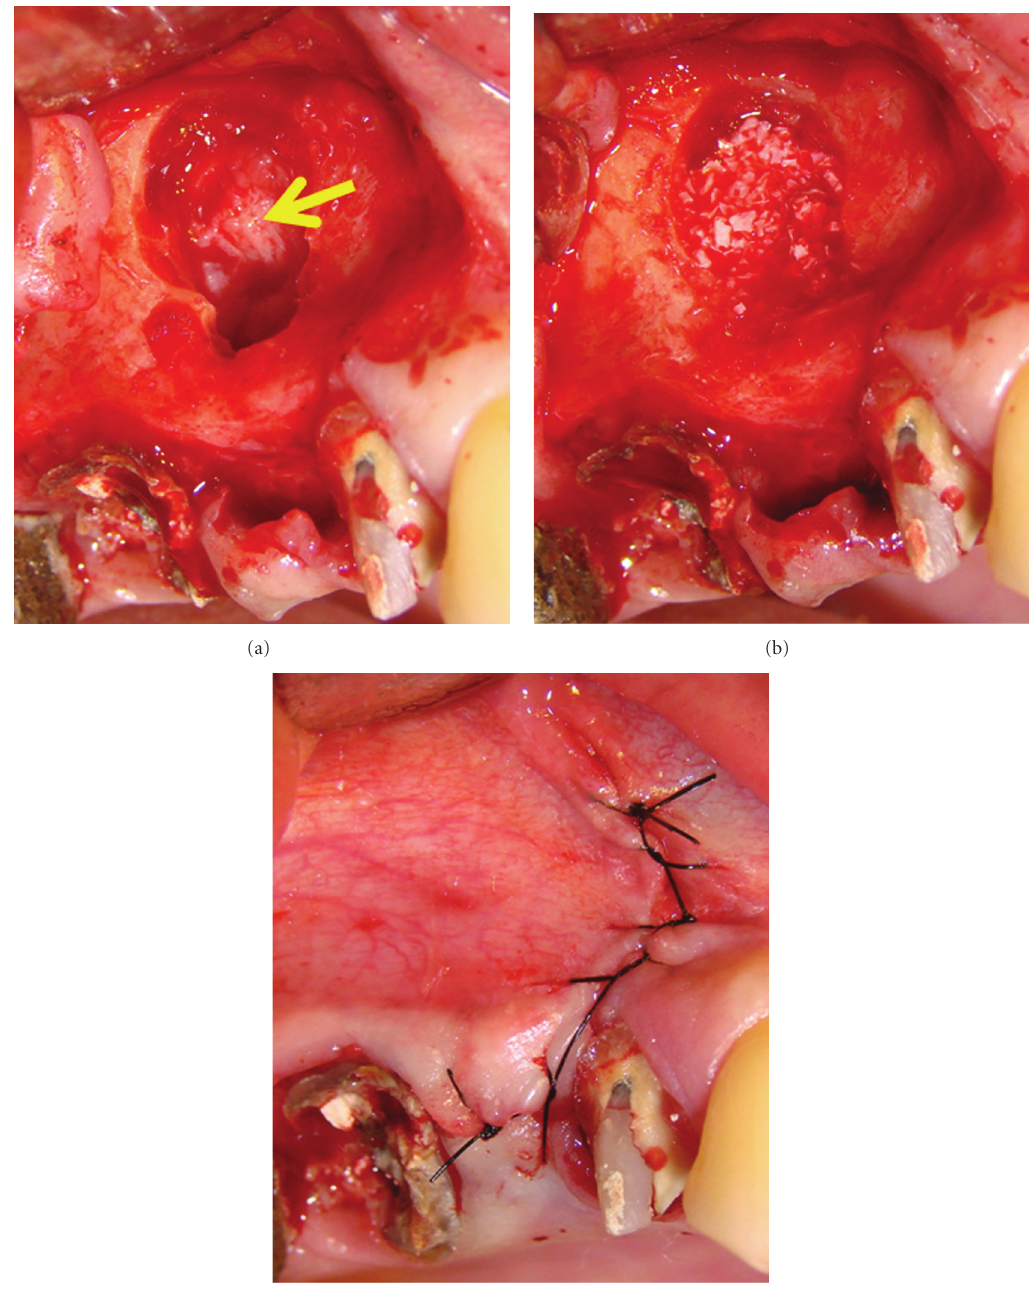
Figure 3: The placement of the autologous membrane, the bone graft, and the suture,